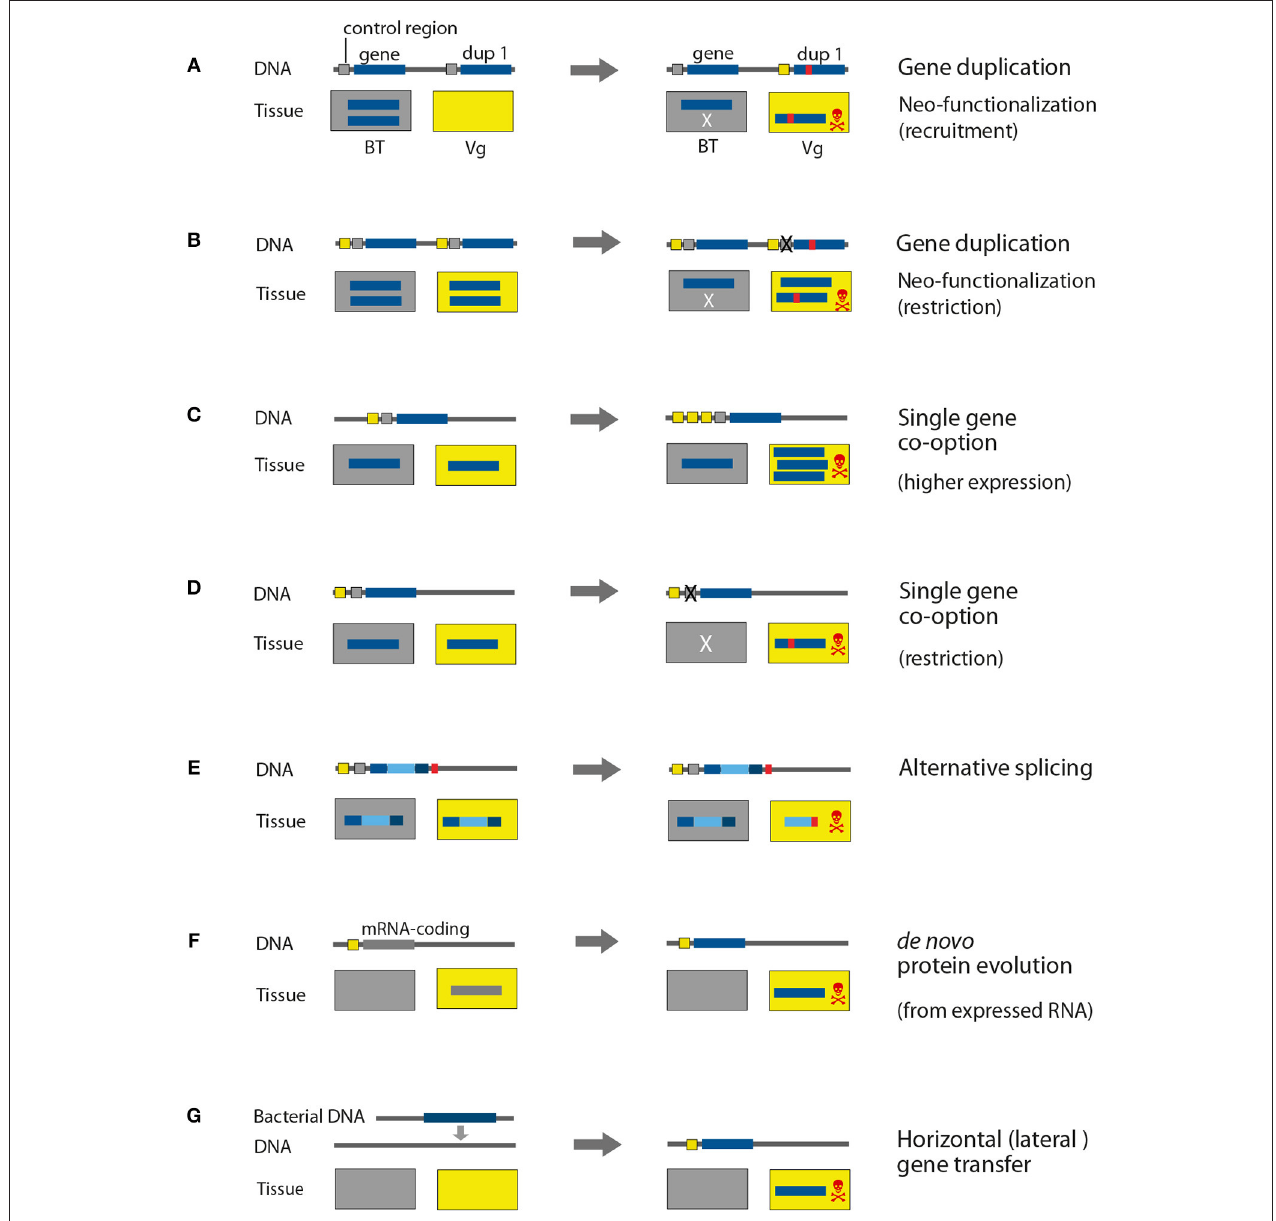
FIGURE 4 | Genomic processes that drive evolution of venom proteins. The control and coding regions on the DNA are marked in different colors for genes that are expressed in body tissue (gray) and venom gland tissue (yellow). The rectangles represent the expression location, Vg, venom gland; BT, body tissue. For simplification reasons only one type of body tissue is depicted, in contrast to normally many different types of tissue in organisms. X illustrates the elimination of control regions and lack of expression in the respective tissue. (A,B) Gene duplication, (C,D) single gene co-option, (E) alternative splicing, (F) de novo protein evolution, (G) horizontal gene